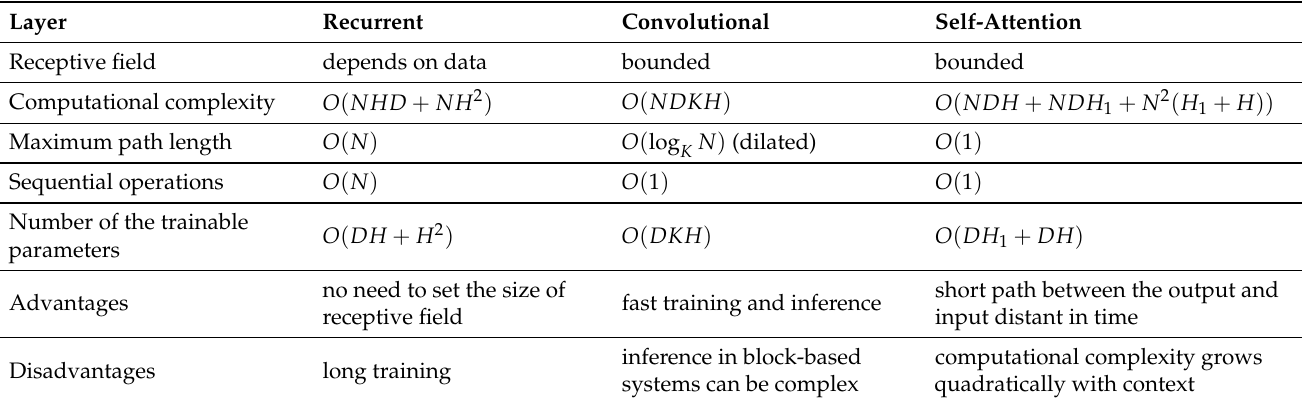
Table 2. Comparison of the properties of causal layers for a case when a sequence of N D -dimensional vectors is transformed to a sequence of N H -dimensional vectors. K is the kernel size. H 1 denotes dimension of query and key vectors in self-attention